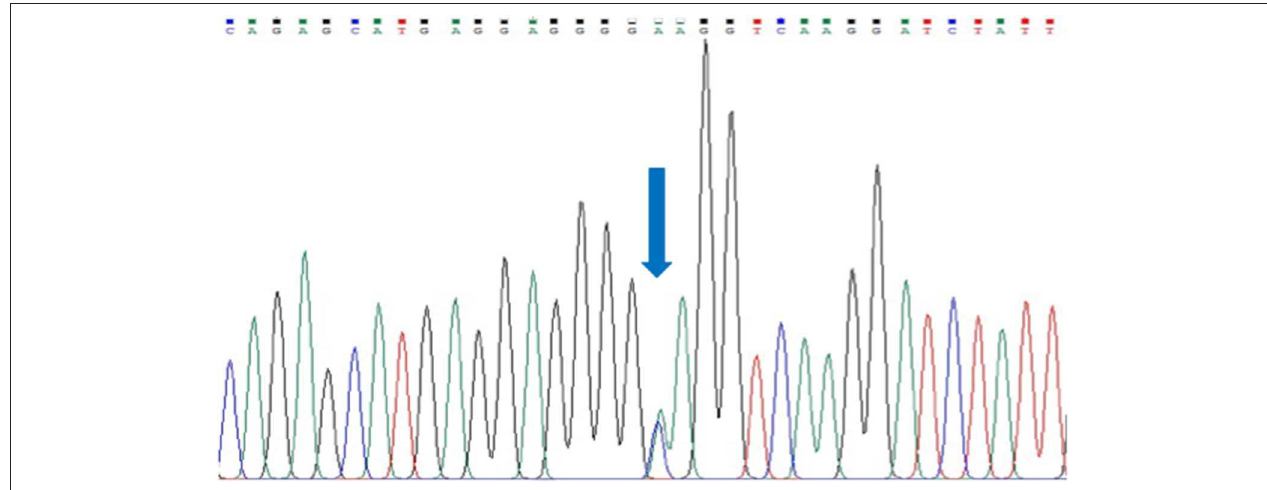
TABLE 3 | SEMA3D common variant frequency in Indonesian HSCR and population databases ( 17, 21). Variant (risk allele) p.Lys701Gln (rs7800072) (C)